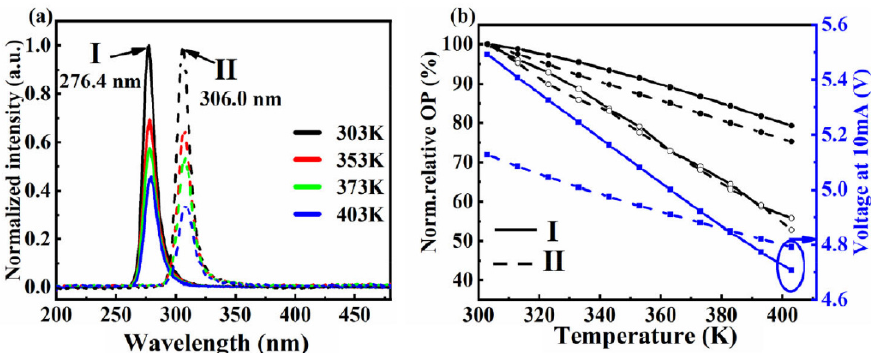
Figure 11. ( a ) The normalized EL spectra of 276 nm and 306 nm LED at current of 0.5 mA. ( b ) The normalized OP at various temperatures. [55] Copyright 2022, AIP.